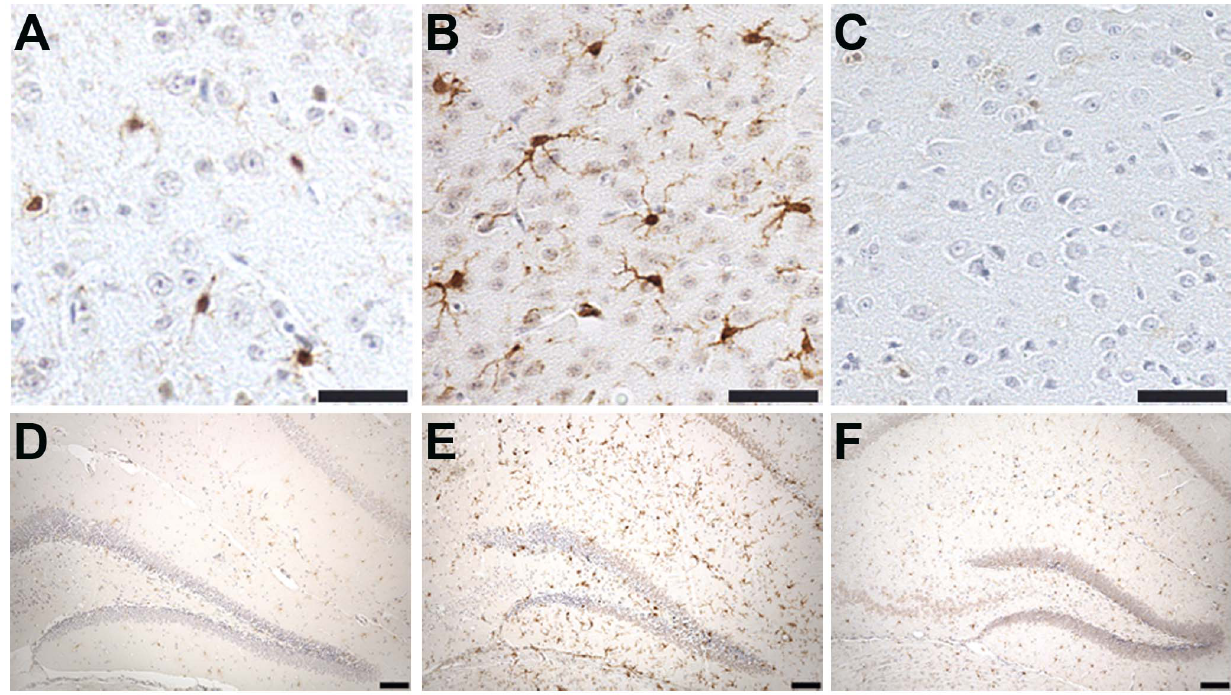
Figure 5. The CCI induced increase in Iba1 immunoreactivity is attenuated by treatment with hydrogen water. Representative images are of Iba1 immunoreactivity in the cortex adjacent to the site of injury (A–C) and the hippocampus (D–F) of sham (A,D), CCI (B,E) and CCI/HW treated (C,F) animals. Scale bars: 50 m m, A–C; 100 m m, D–F.